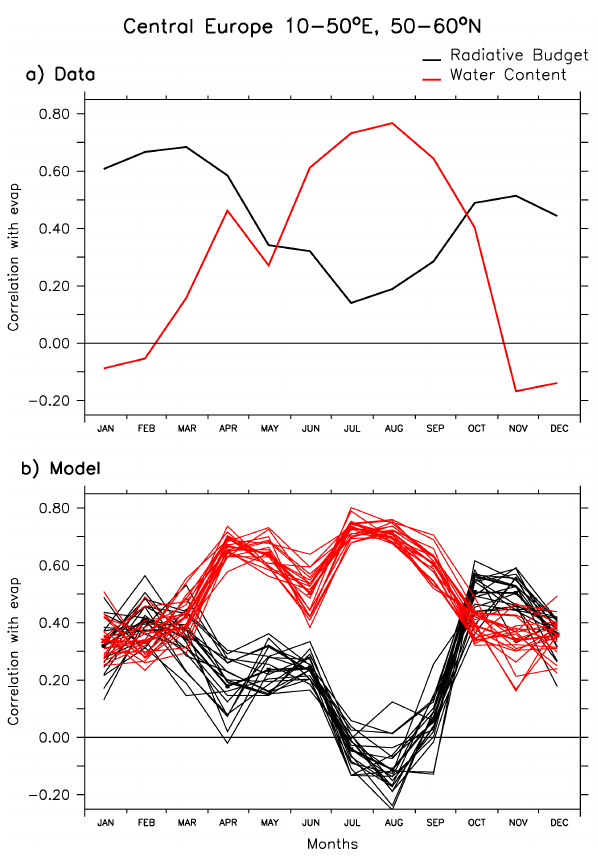
Fig. 6. Correlation between the net radiative forcing and evapotran- Figure 6. Correlation between the net radiative forcing and evapotranspiration (in black) and 2 spiration (in black) and soil water content and evapotranspiration soil water content and evapotranspiration (in red) for a region of Central and Eastern Europe 3 (in red) for a region of Central and Eastern Europe (10–50 ◦ E, 50– (10-50°E, 50-60°N) for different months (on the x-axis) a in a reanalysis from Alkama et al. 4 60 ◦ N) for different months (on the x-axis) (a) in a reanalysis from (2010) over the period 1950-2000 and b in the model simulation the period 1001-1800. The 5 Alkama et al. (2010) over the period 1950–2000 and (b) in the model simulation, the period 1001–1800. The different lines in (b) different lines in panel b correspond to a computation every 50 years starting from 1001-1050 6 correspond to a computation every 50yr starting from 1001–1050 (until 1800-1850). This has been done in order to evaluate the stationarity of the relationship 7 (until 1800–1850). This has been done in order to evaluate the sta- in the model. 8 tionarity of the relationship in the model.